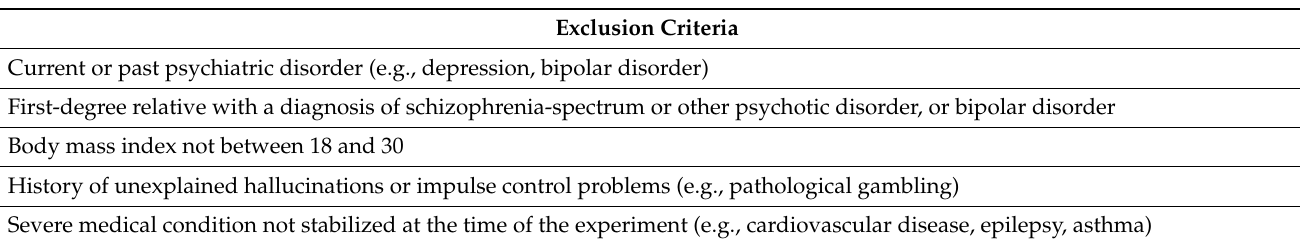
Table 5. Exclusion criteria for the